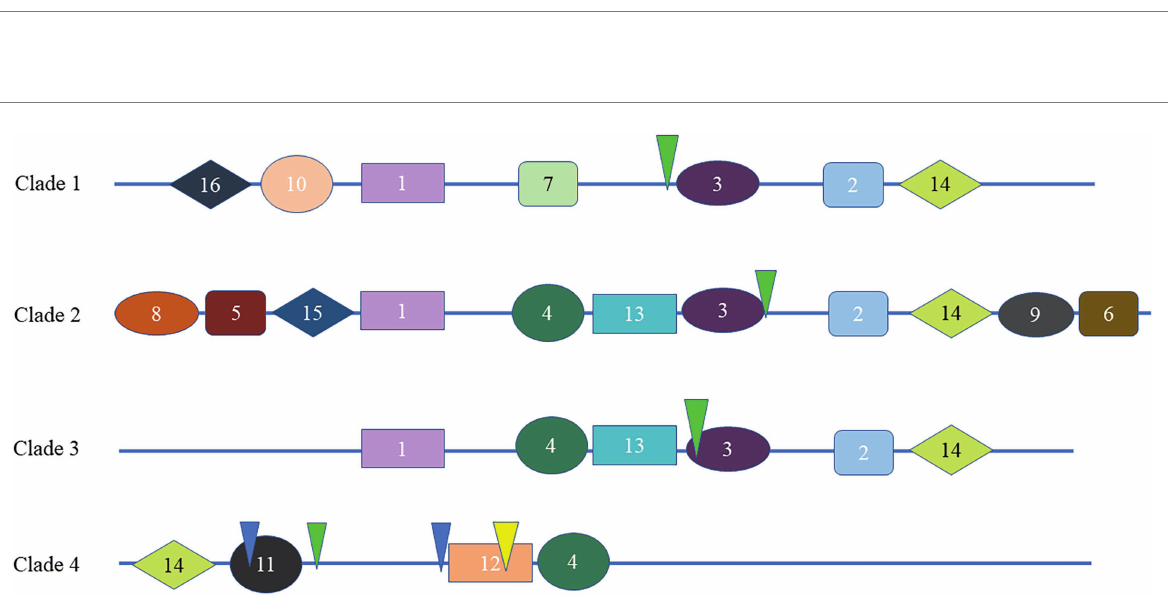
FIGURE 3 Different motif distribution of the SHI/STY proteins and exon–intron organization in different clades. The different colorful patterning represents the relative positions of motifs on the protein sequence in the different clades. The inverted triangles with yellow, green and blue marks indicate the insertion positions of phase 0, 1 and 2 introns,